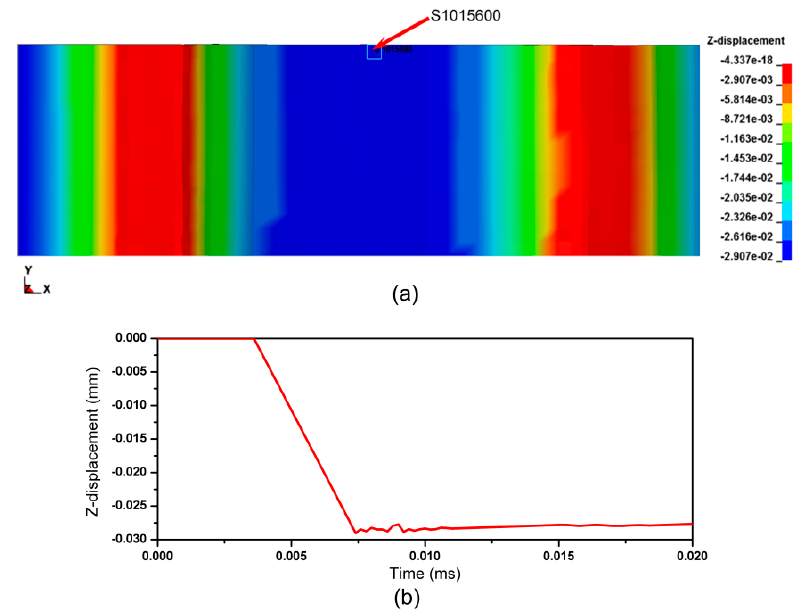
Figure 21. ( a ) The position chosen to plot the curve of Z -displacement changing with the time and ( b ) curve of Z -displacement for the workpiece with the thickness of 30 µ m changing with the time under the laser pulse energy of 1800 mJ.